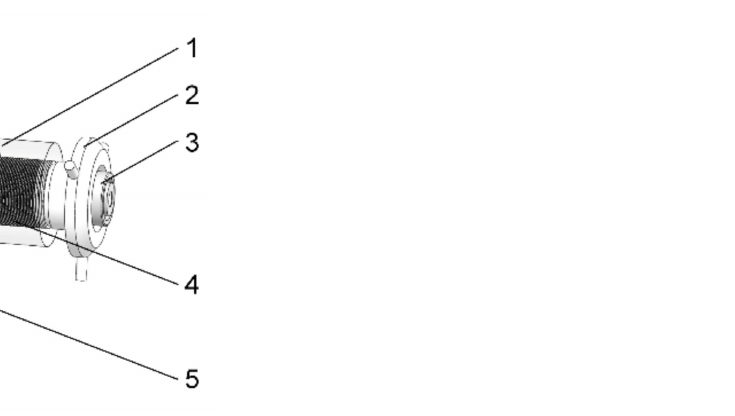
Figure 2. Grinding wheel clearance adjustment device. 1. Housing; 2. Handle (Figures 2-2 and 1a-3 are the same part); 3. Small sleeve; 4. Large sleeve; 5. Right grinding wheel holder (Figures 2-5 and 1b-14 are the same part).